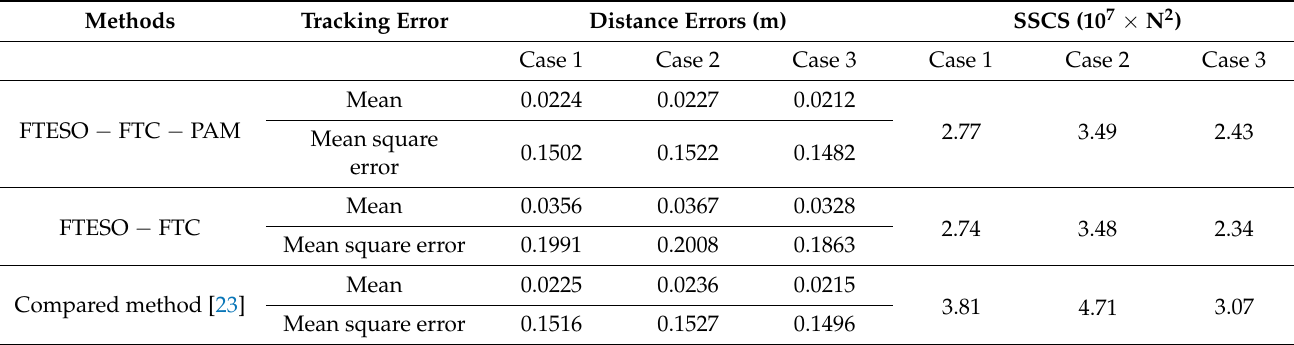
Table 1. Compared results of the three methods under Cases